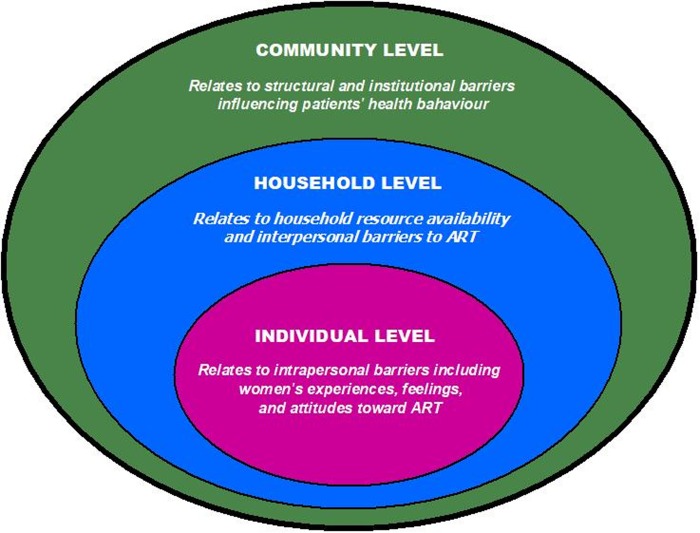
The social ecological model[39].